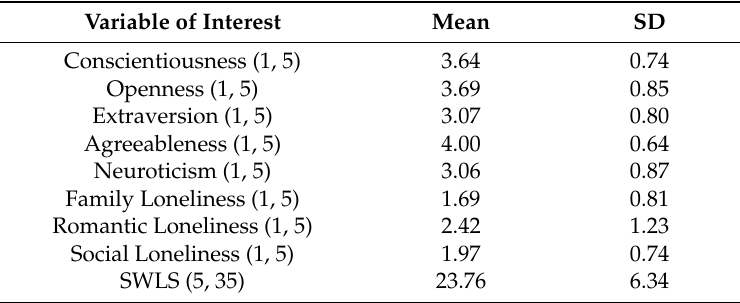
Table 2. Results of descriptive of the variables of